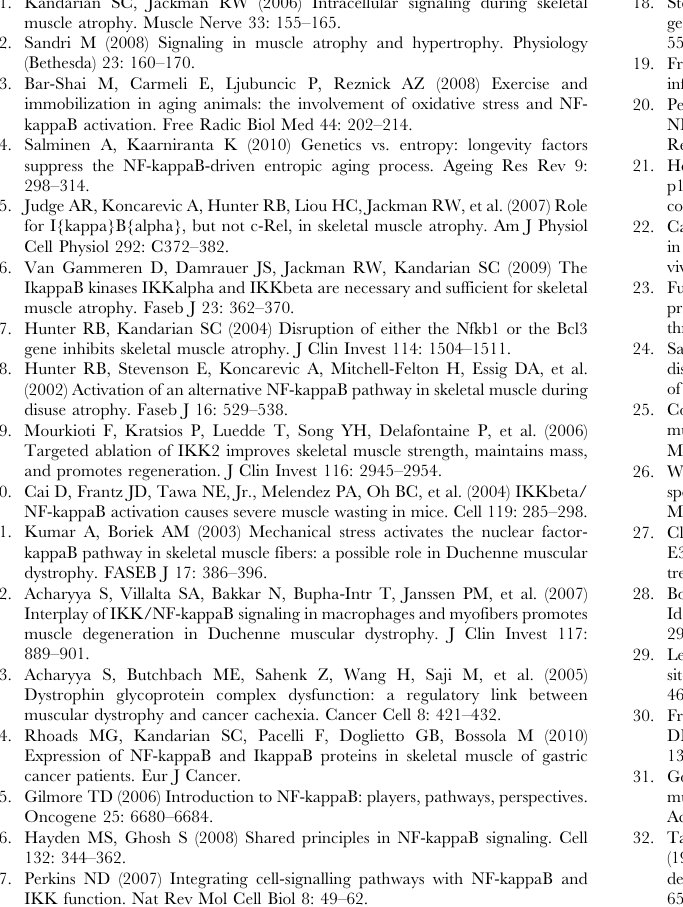
Table S1 Muscle weights for weight bearing (WB) and hind limb unloaded (HU) mice.